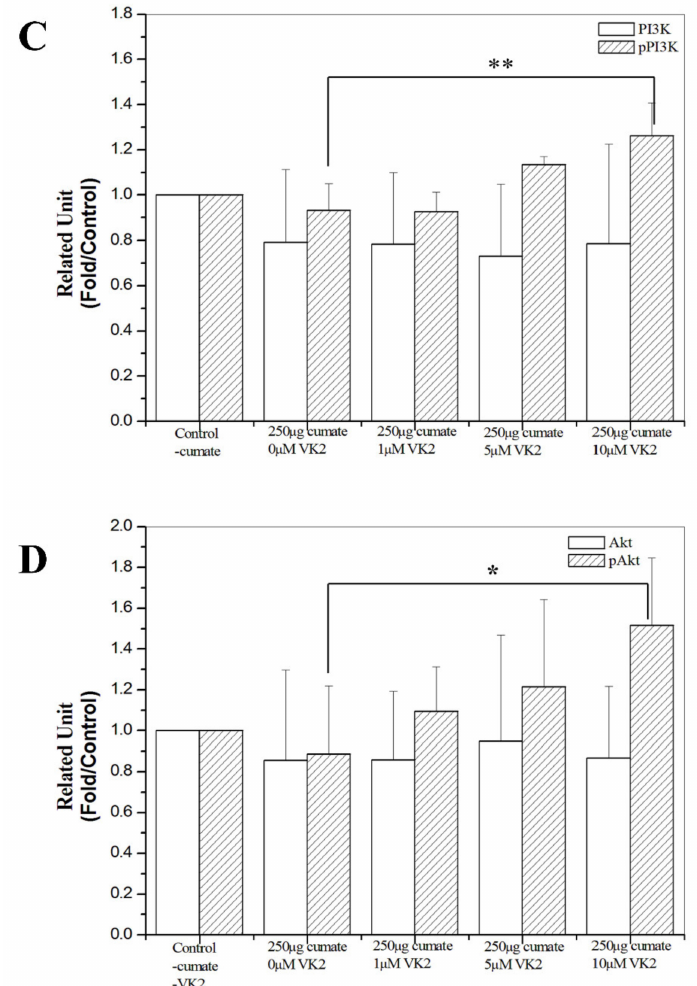
Figure 5. Effect of vitamin K2 on A β -mediated PI3K/Akt phosphorylation. β -CTF/C6 cells were treated with 250 µ g cumate and 0–10 µ M of vitamin K2 (VK2) for 72 h. In total, 60 µ g total protein from each sample was used for Western blot analysis with monoclonal antibodies against PI3K and phosphorylated-PI3K (pPI3K) ( A ) and Akt and pAkt ( B ). Shows the relative protein level/actin for PI3K and pPI3K ( C ) and Akt and pAkt ( D ). Data are means ± SD. * p < 0.05 and ** p <